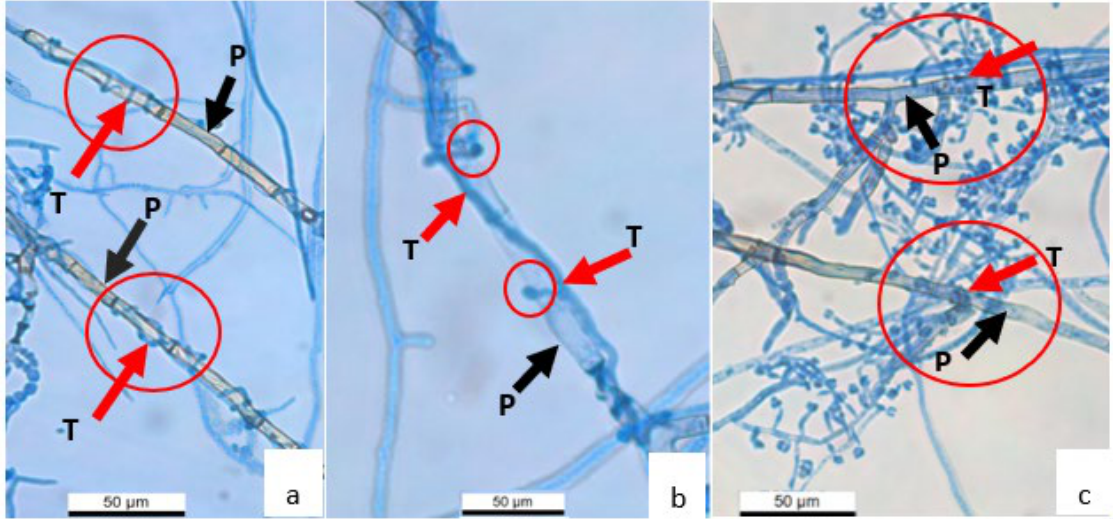
Figure 2. Mycoparasitism by the Trichoderma strain #5001 (T) on P. noxium strain B (P). ( a ) Tricho- derma coiled around hyphae of P. noxium strain B (X 400), ( b ) appressorium-like structure (X 400) and ( c ) Trichoderma growth over P. noxium strain B hyphae (X 400). The red and black arrows indicate the Trichoderma and P. noxium , respectively. Circles indicate the coiling, appressorium-like structures and Trichoderma overgrowth on P. noxium .